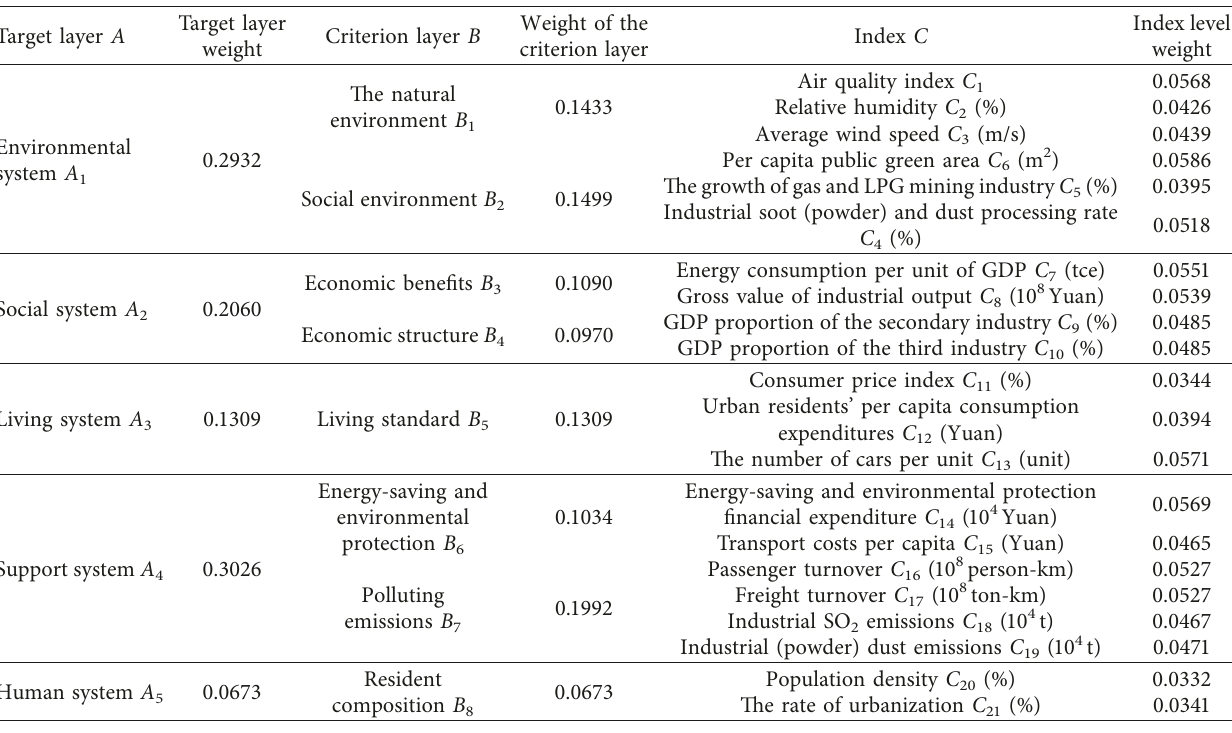
Table 1: Evaluation index system of the urban human settlements environment.